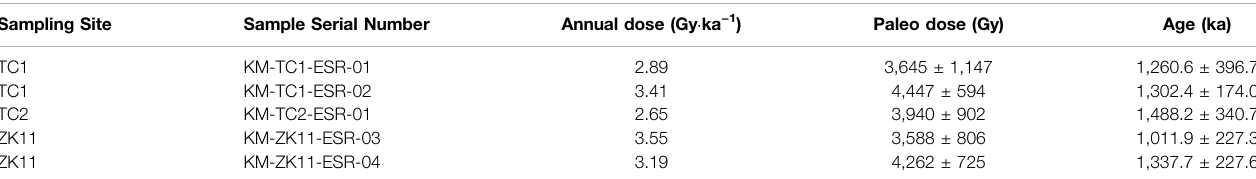
TABLE 3 | ESR dating results of the kouma